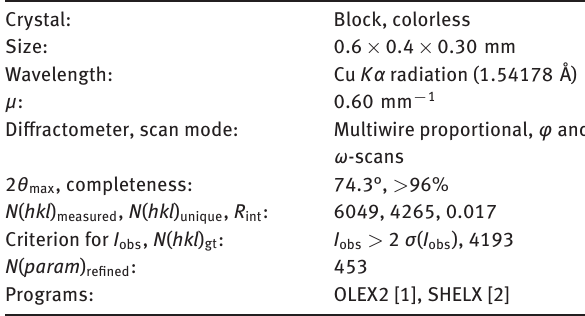
Table 2: Fractional atomic coordinates and isotropic or